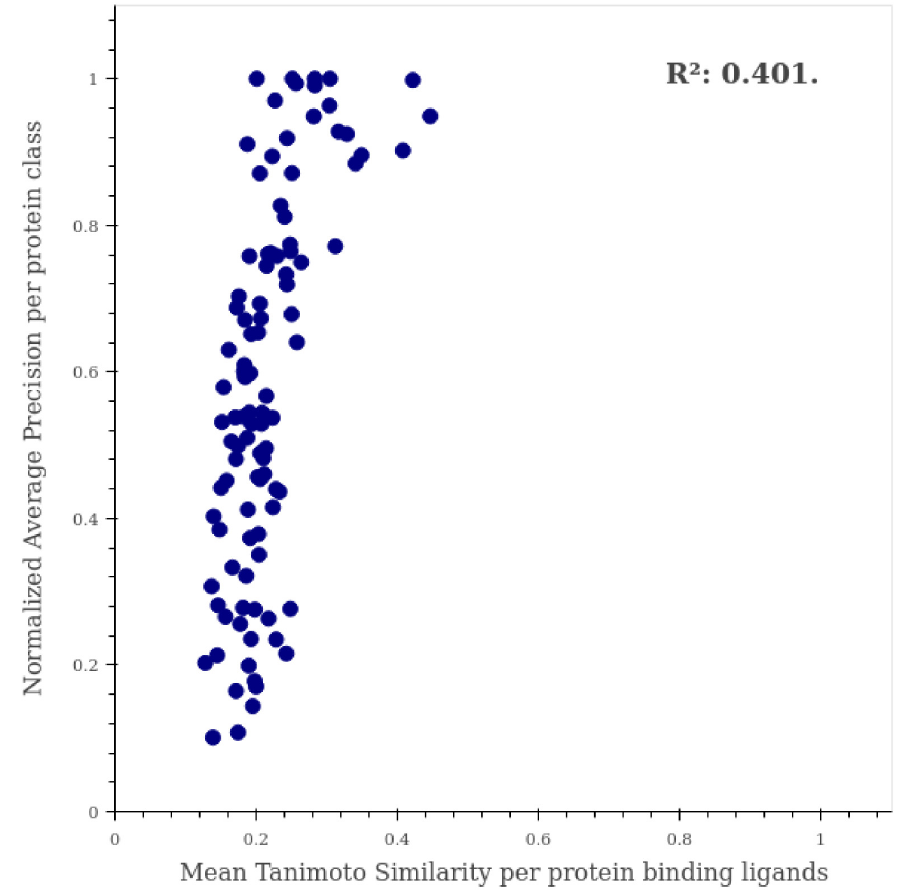
Fig 7. Correlation between normalized AP and tanimoto Similarity per protein. Performance per protein in PharmaNet is shown as a function of the averaged Tanimoto Coefficient in molecules of the same class. R 2 is reported for estimating correlation between these two